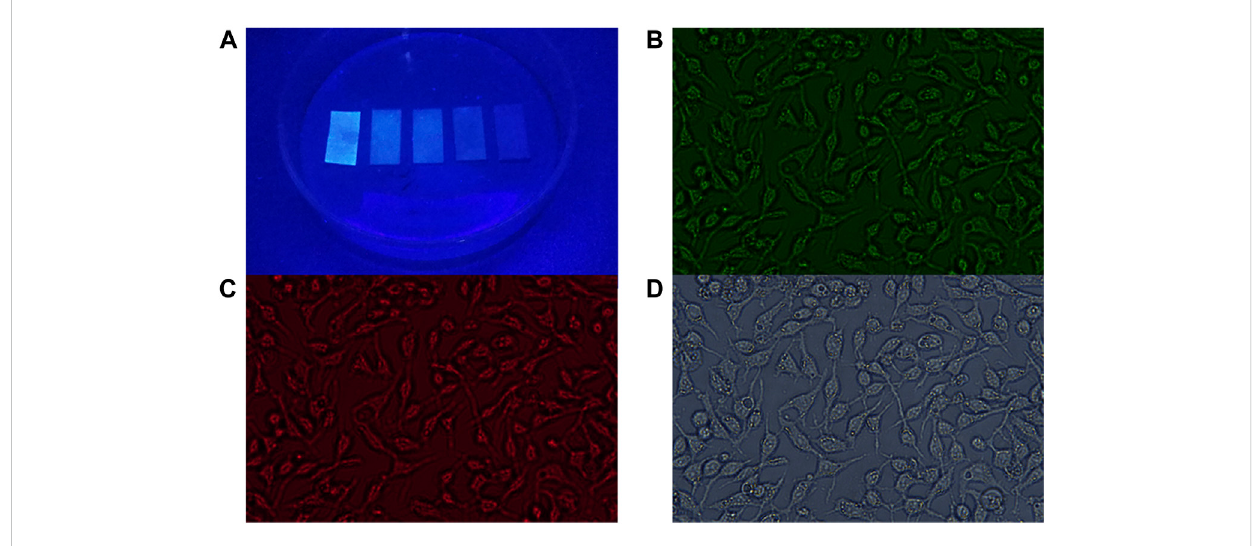
FIGURE 7 (A) CapturedPLemissionofCDsinseriesconcentrationsofFe 3+ ionssolution(0,10,50,100,and500 μ Mfromlefttoright).Confocallaserscanning microscopy images of CDs in cells (B) excitation wavelength of 465 – 495 nm; emission was collected at 512 – 552 nm; (C) excitation wavelength of 540 – 580 nm; emission was collected at 600 – 660 nm; (D) bright fi